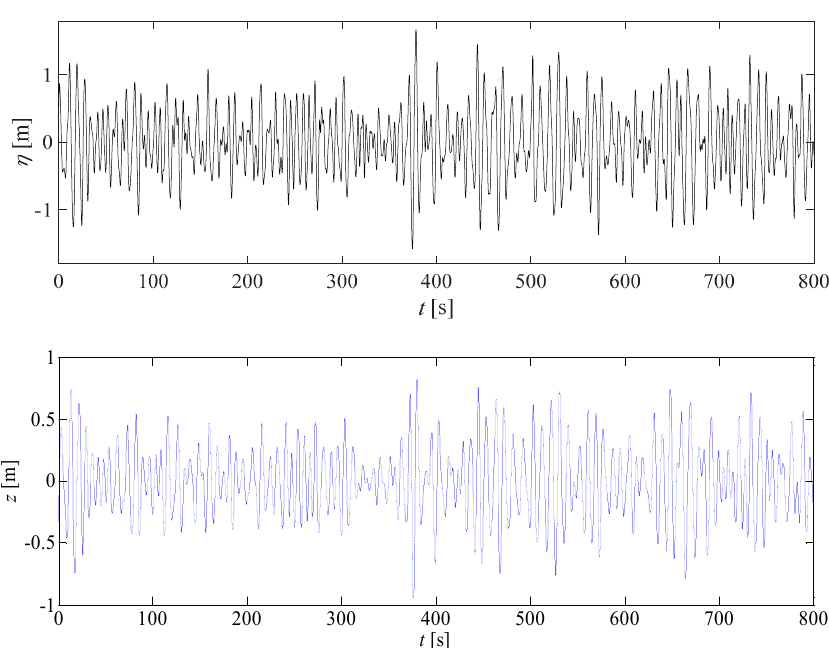
Figure 3. A time-history example of the wave elevation η (upper) and buoy displacement z (lower) for a vertical truncated cylindrical buoy with r = 10 m, d = 5 m, m n = 1, c p = 10 6 N.s/m, k c = 10 6 N/m, T e = 8 s and H s = 2 m.